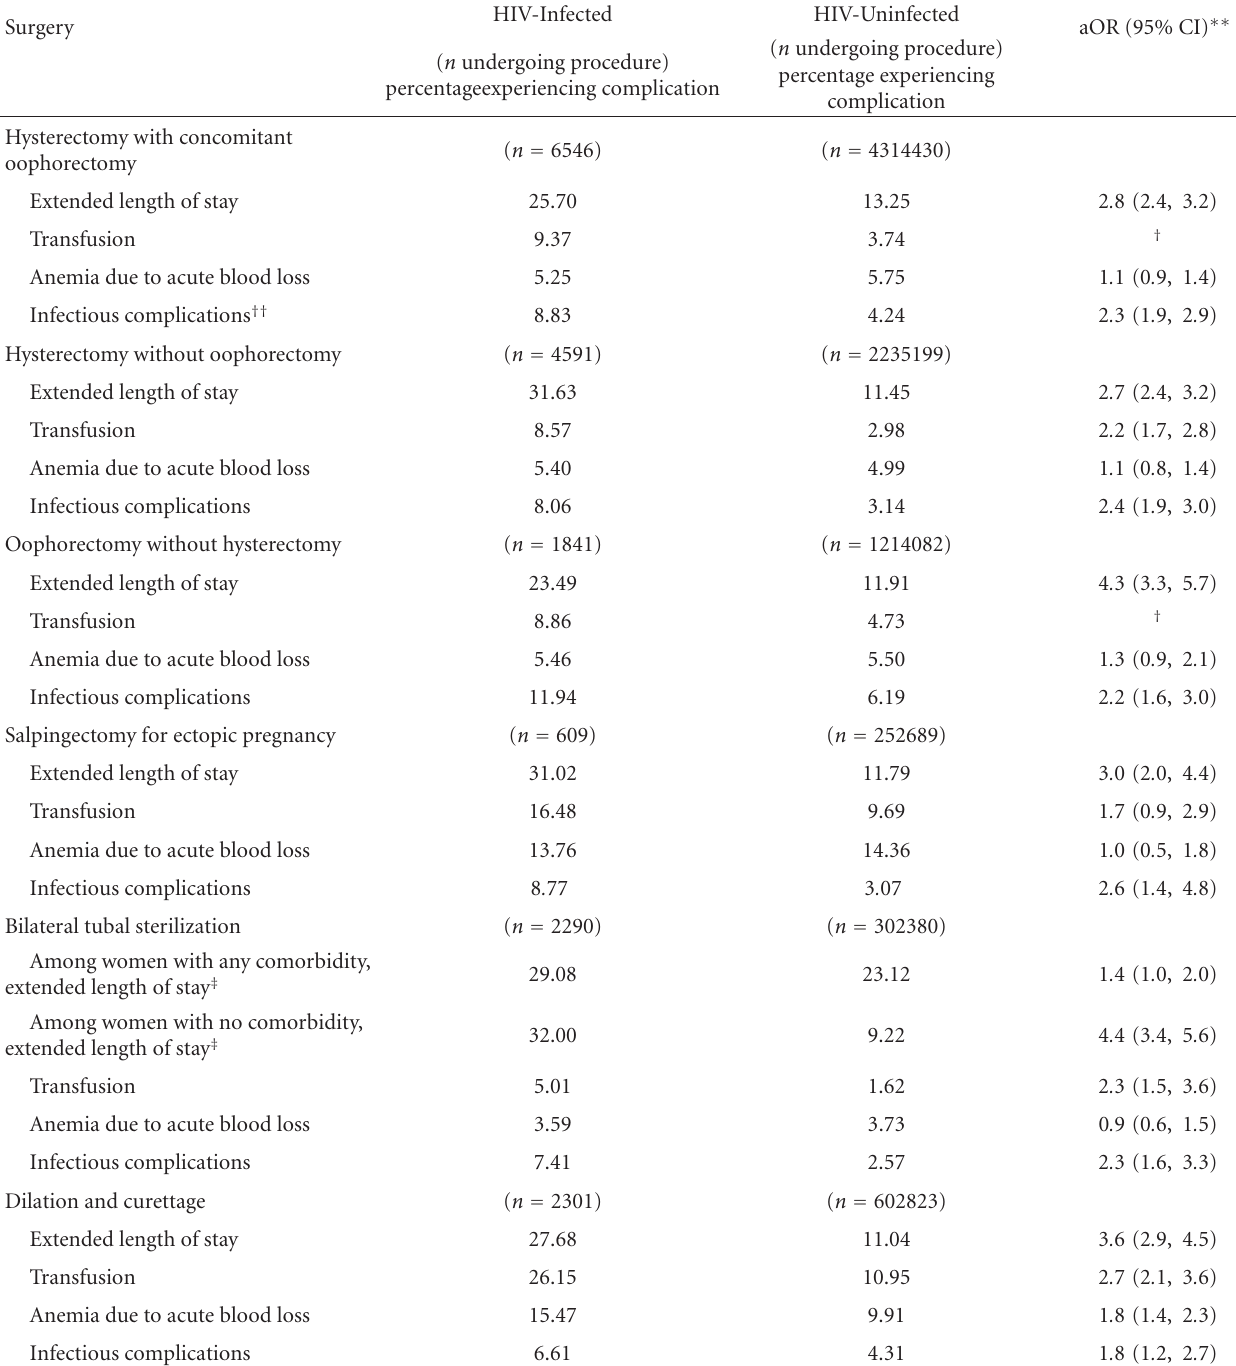
Table 3: Estimated percentages with specific complications ∗ and adjusted odds ratios for experiencing complications, by HIV status, among selected gynecological surgeries (United States,